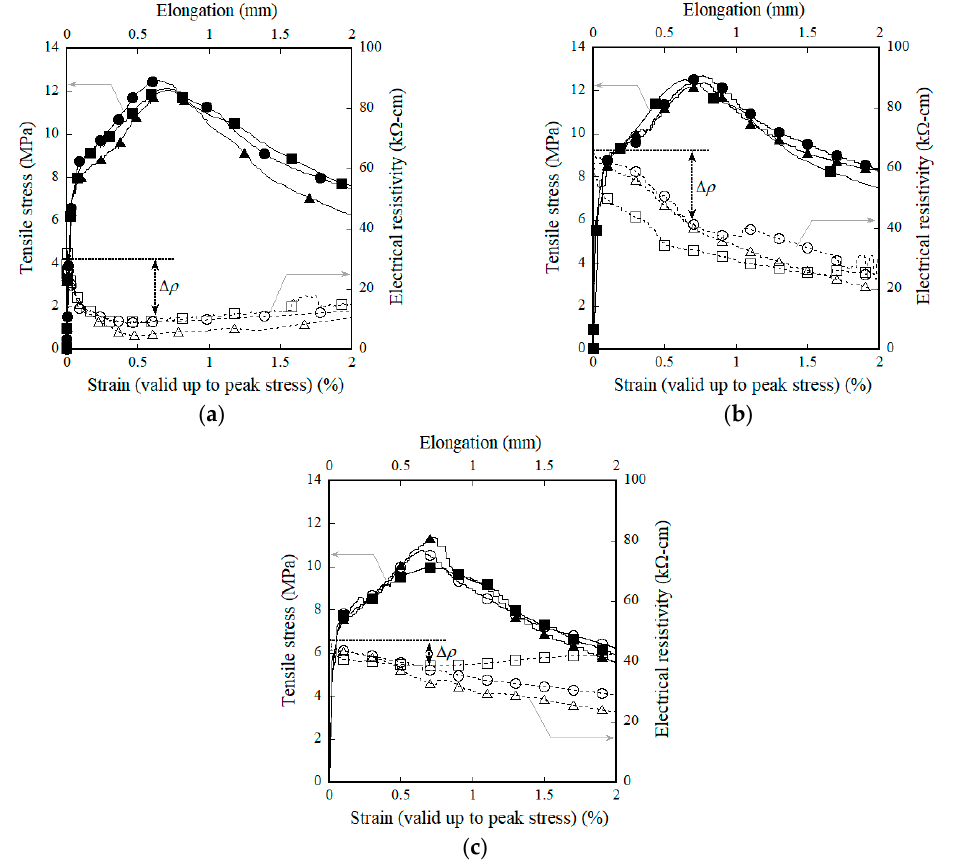
Figure 7. Electromechanical responses of HPFRCCs containing MGFs under tension: ( a ) M0.00, ( b ) M0.05, and ( c ) M0.10. Table 4. Tensile parameters of HPFRCCs containing MGFs.